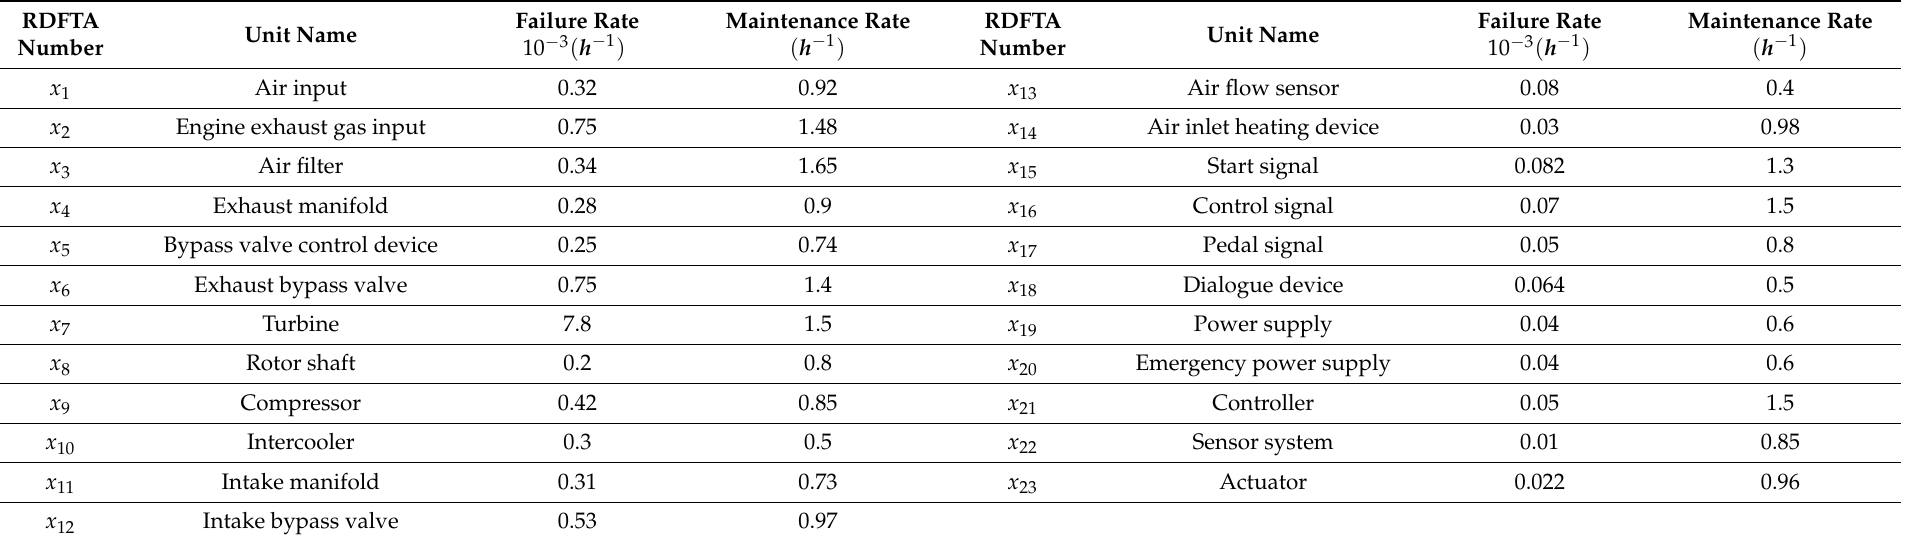
Table 10. The RDFTA reliability parameters of the pressurization and control system